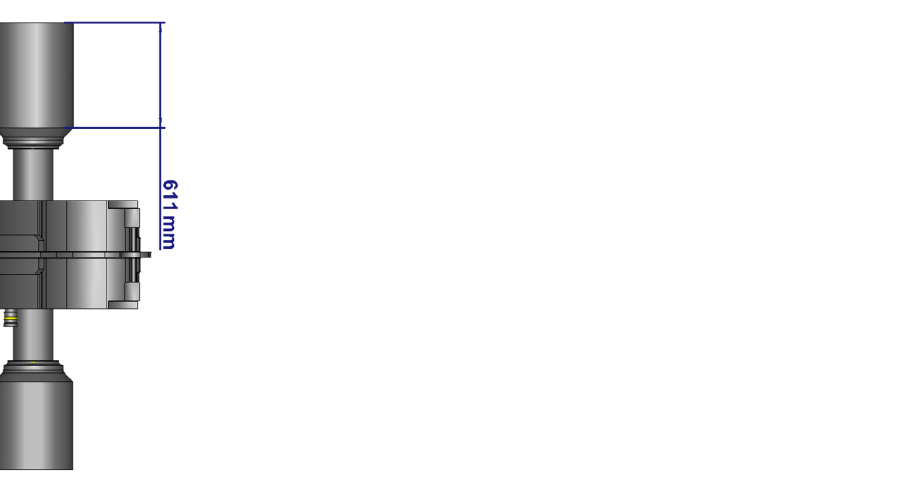
Figure 14. Asymmetrical sliding shorts position to counteract the asymmetry introduced by the coupler. The parasitic electric field component produced in the standard, symmetric sliding shorts, configuration was already presented in Figure 10. Same electric field analysis has been performed for the “asymmetric shorts” configuration. The electric field produced by the latter configuration is reported again in Figure 15 for easier comparison with the same color range scale of Figure 16 to simplify the comparison. Thanks to the applied asymmetry, it can be observed that the undesired electric field parasitic component corresponding with the center of RF cavity has been reduced to negligible values.